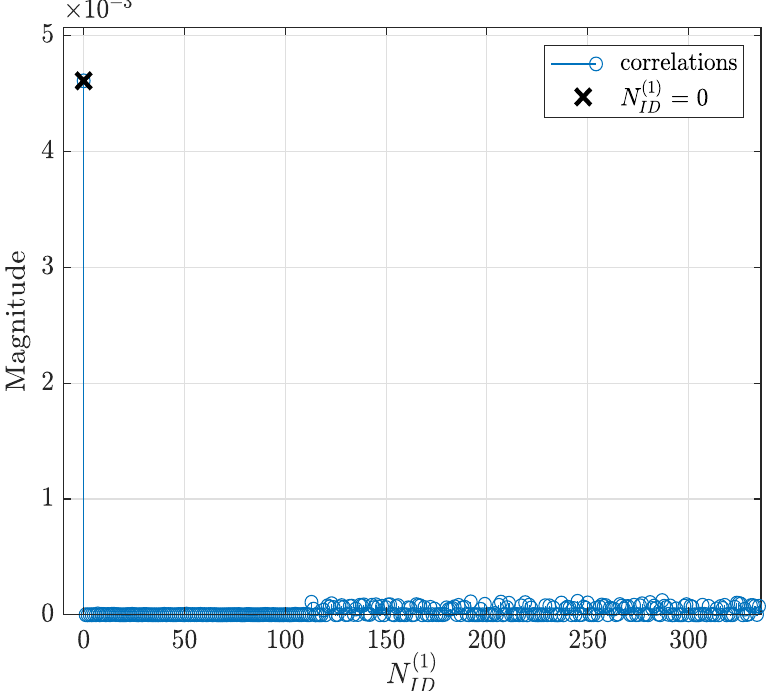
Figure 9. Secondary synchronization signal